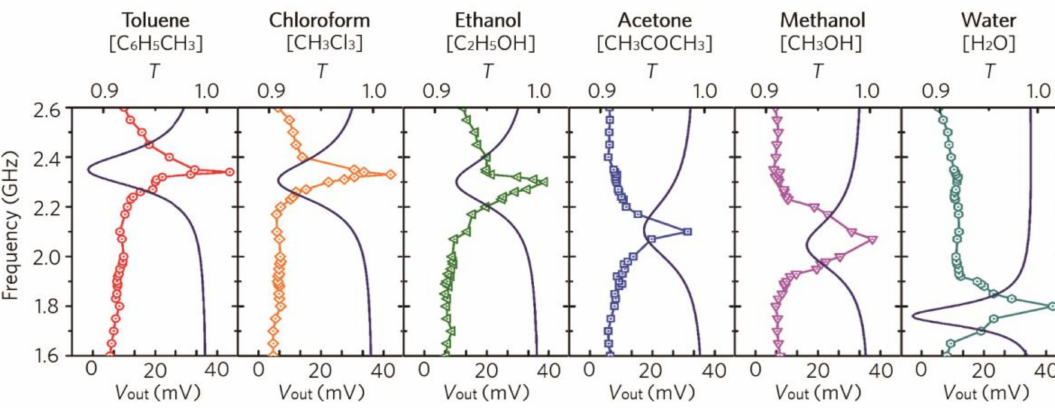
Figure 3. Simulated transmission spectra (line) and measured output voltage ( V out ) spectral (symbol) of the proposed metamaterial sensor system for various chemical